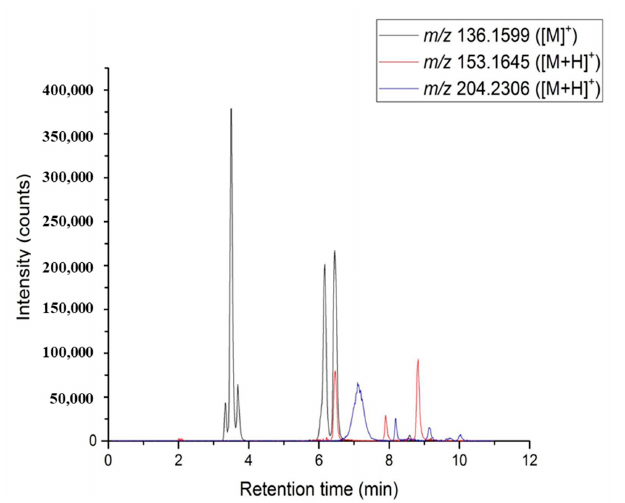
Figure 2. Overlay of EIC chromatograms: (black line) m / z 136.1599 for monoterpenes, (red line) m / z 153.1645 for oxygenated monoterpenes, (blue line) m / z 204.2306 for sesquiterpenes.